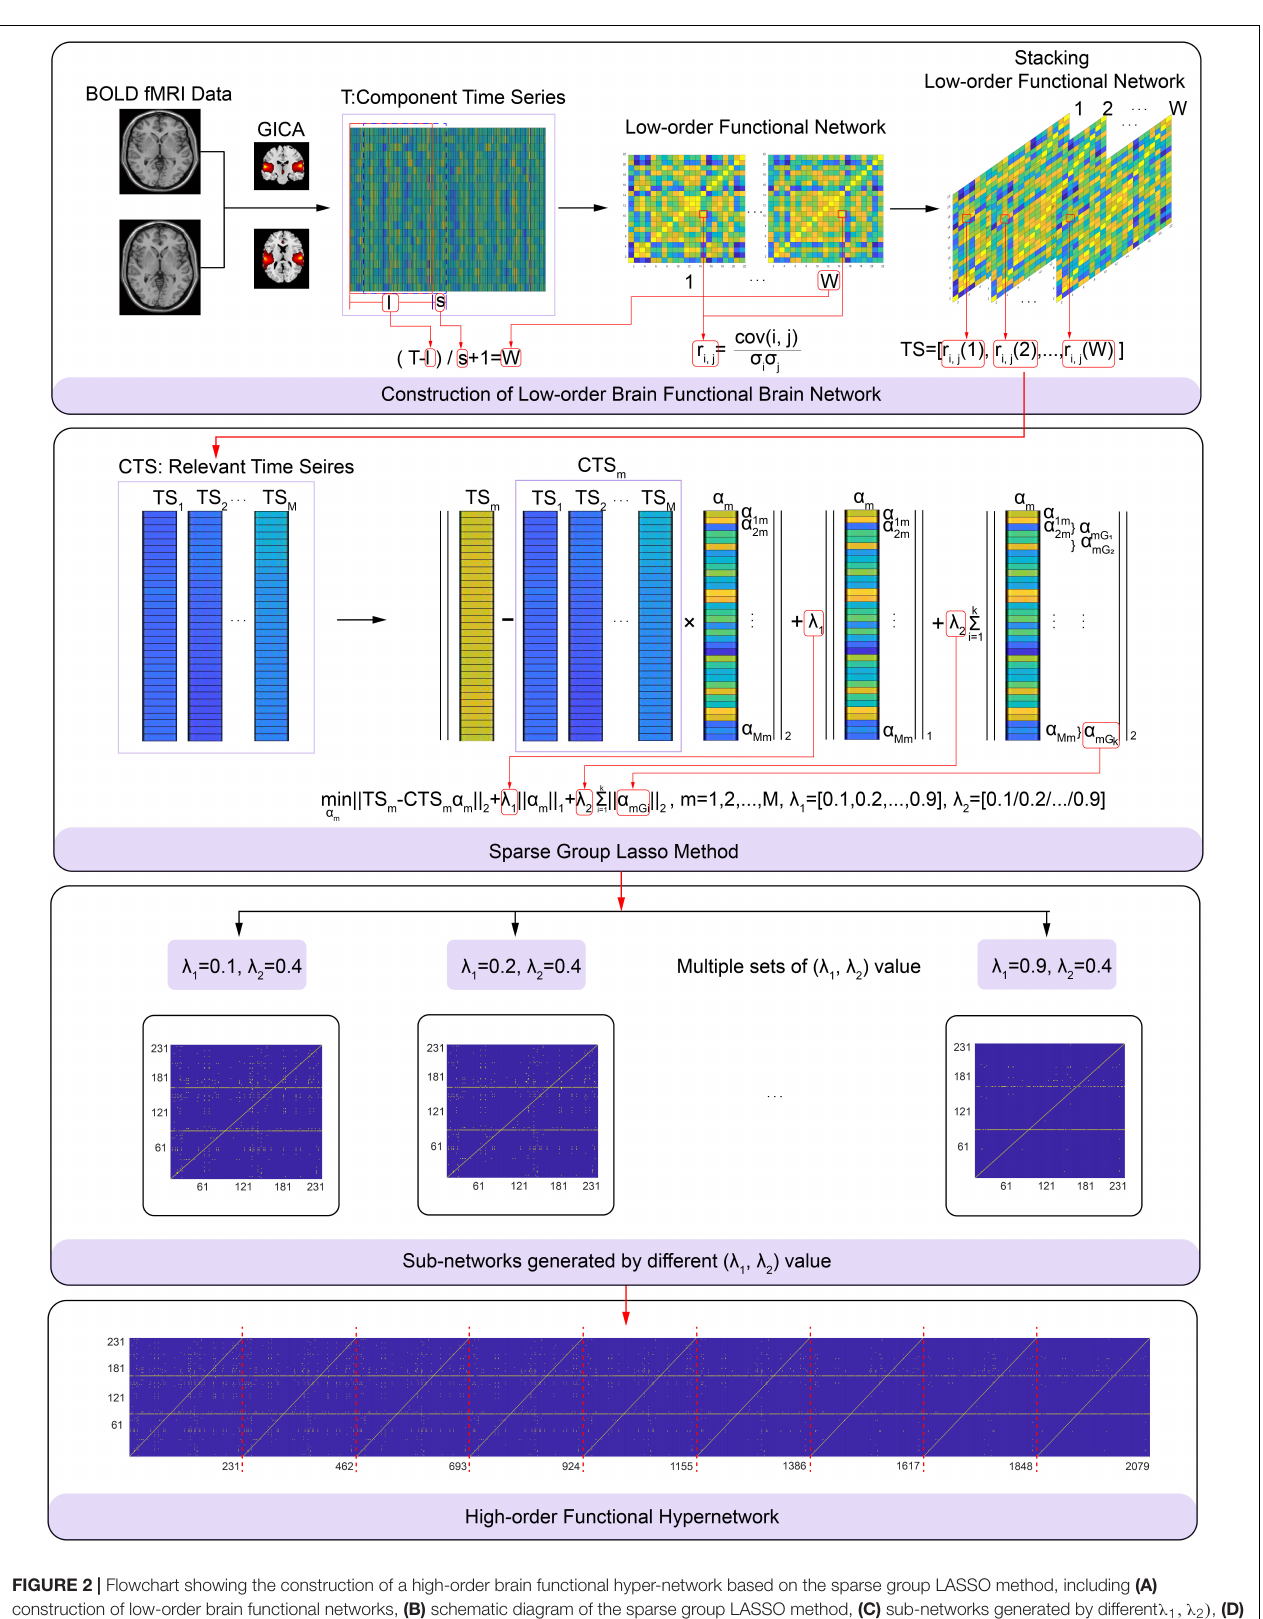
FIGURE 2 | Flowchart showing the construction of a high-order brain functional hyper-network based on the sparse group LASSO method, including (A) construction of low-order brain functional networks, (B) schematic diagram of the sparse group LASSO method, (C) sub-networks generated by different λ 1 , λ 2 ) , (D) high-order brain functional